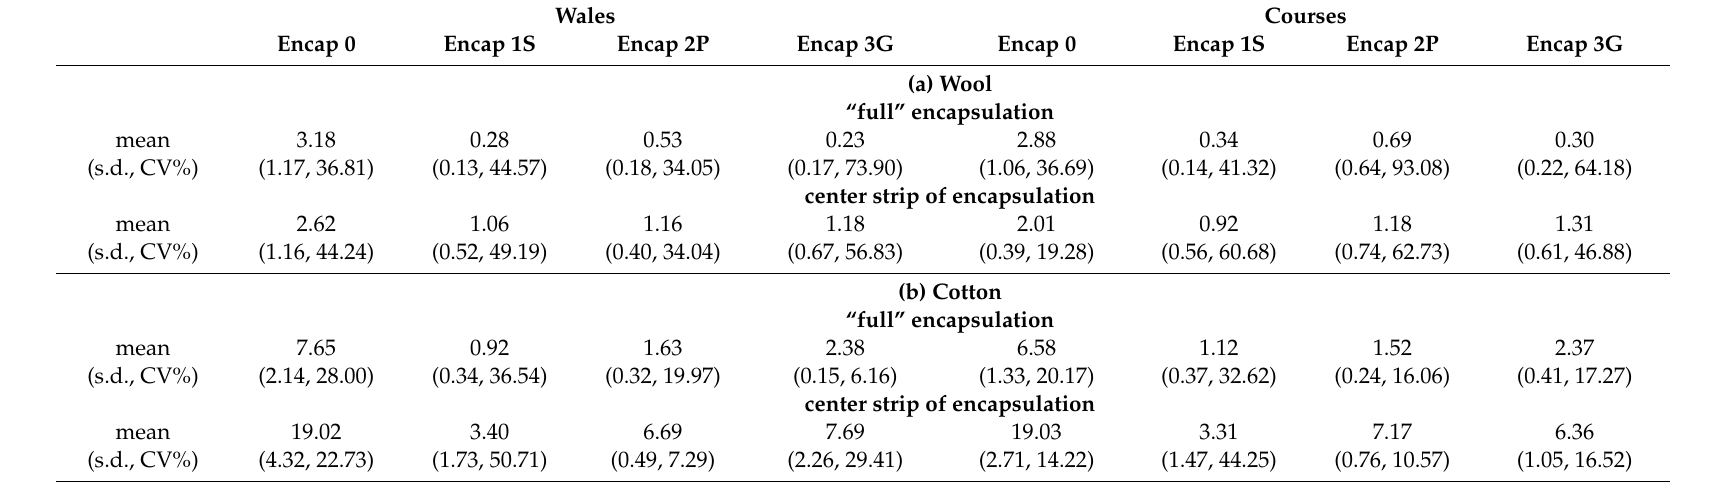
Table 3. E ff ect of functionalization on electrical conductivity (S /